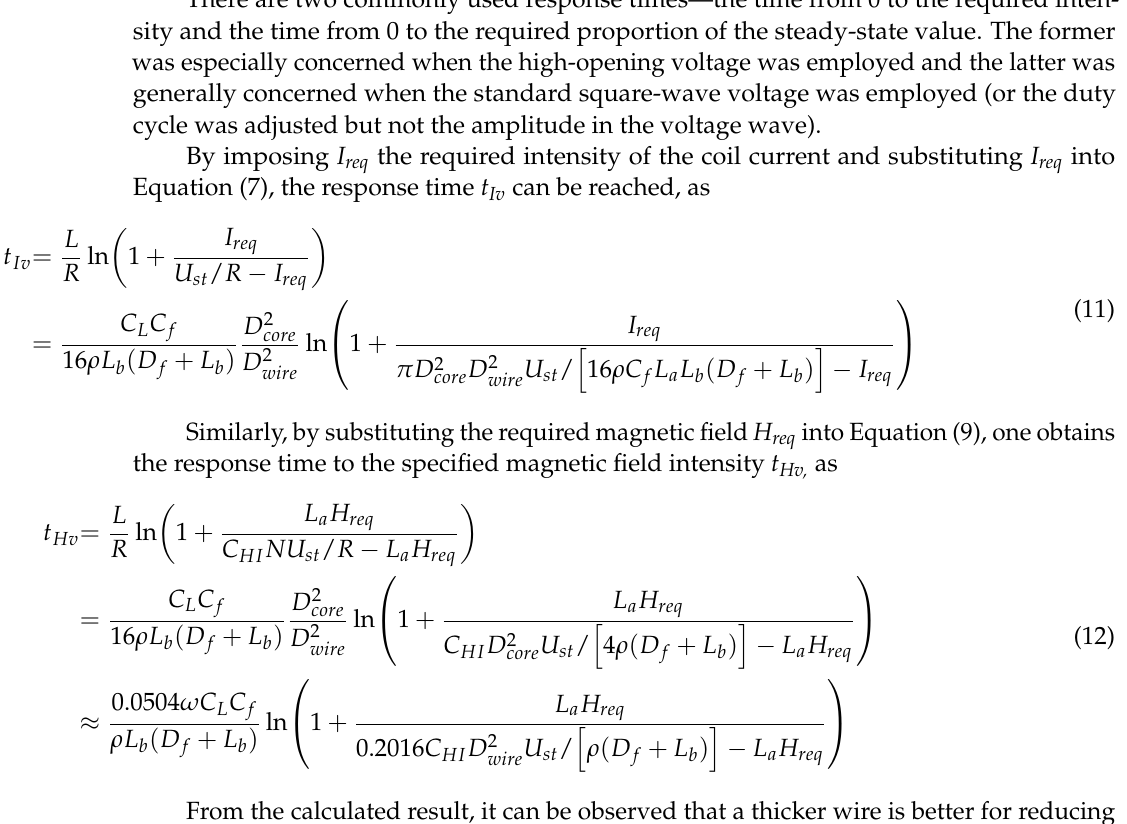
Figure 10. Steady-state magnetic field of the square-wave response from the test and